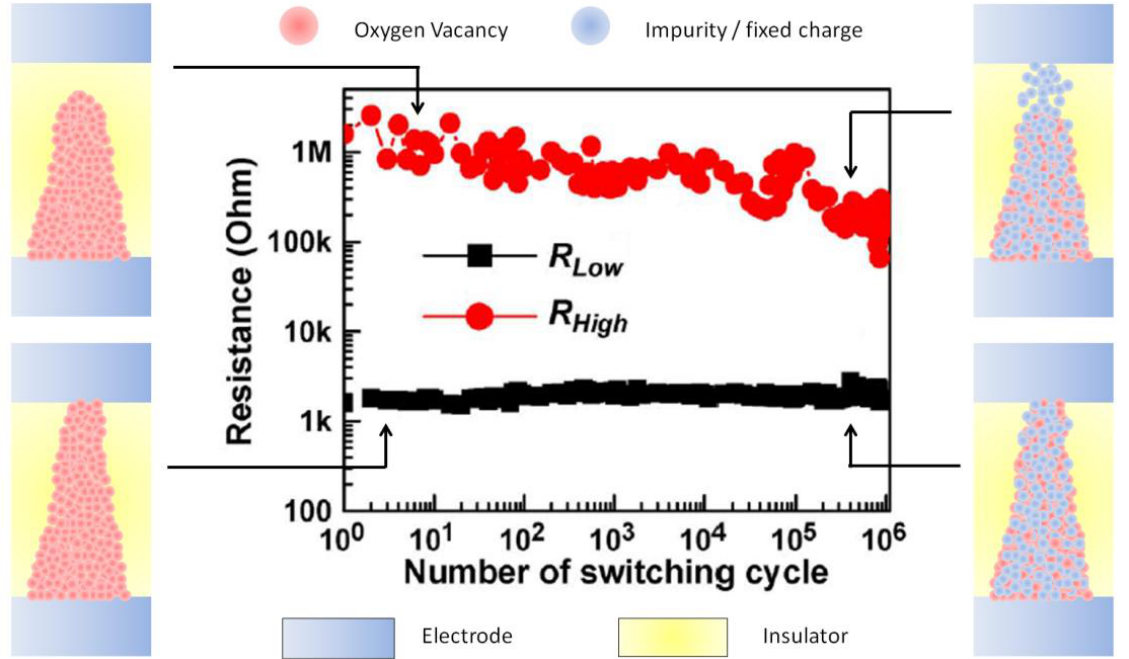
Figure 6. R ratio depending on the switching cycle in a TiN/TiO ON/OFF cell. The schematics show the shape of the filament in each state for the first and last cycles. Modified and reprinted with permission from [7]. Copyright 2008